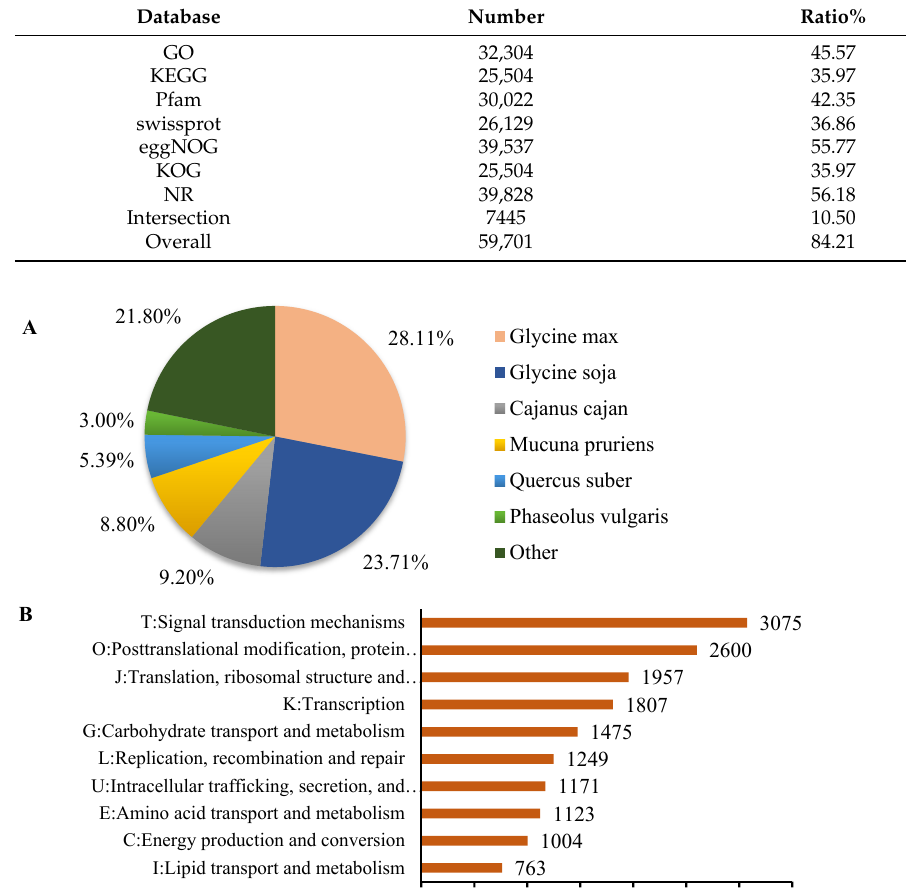
Figure 1. NR functional and eggNOG classified annotation of transcriptome genes. ( A ) Species homology distribution analysis of unigenes in NR database. The ratio indicates the number of unigenes